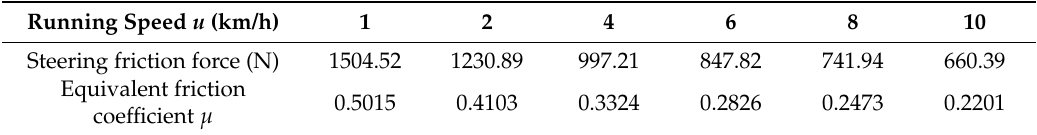
Figure 3. Simulation results of low-speed steering friction force: ( a ) Curves of steering friction force; and ( b ) fitting curve of the equivalent friction coefficient with the running speed of the tire. Table 2. Simulation results of low-speed steering friction force.